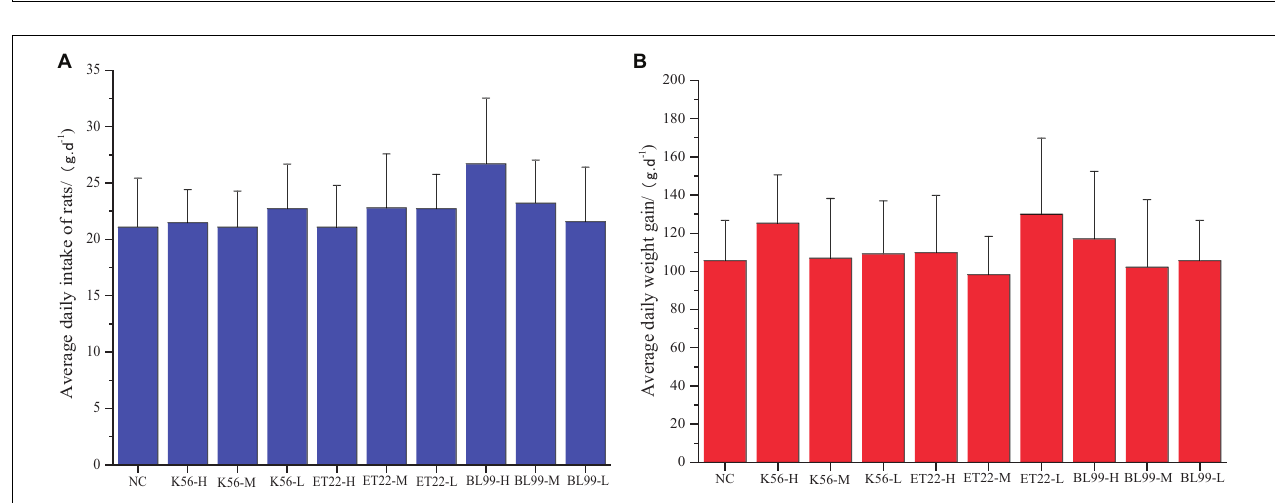
FIGURE 5 | The effect of tested bacterial strains on the food intake and body weight increment of subacute rats. NC, PBS group; K56-H, ET22-H, and BL99-H denoted fed with high dose of K56, ET-22, and BL-99 for rats. K56-M, ET22-M, and BL99-M denoted fed with medium dosed (half of high dose) of K56, ET-22, BL-99 for rats, respectively. K56-L, ET22-L, and BL99-L denoted fed with medium dose (quarter of high dose) of K56, ET-22, and BL-99 for rats, respectively. The highest dose of K56-L, ET22-L, and BL99-L was 5.25 × 10 11 , 5.25 × 10 11 , and 7.5 × 10 11 CFU/kg, respectively. (A) Average daily intake of rats. (B) Average daily weight